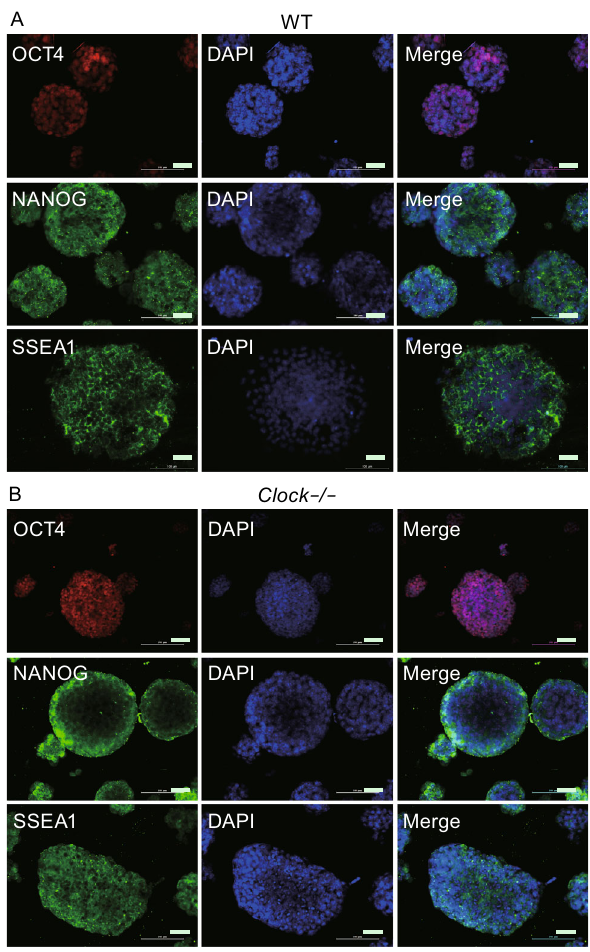
Figure 3. Clock -/- mESCs express pluripotent markers OCT4, NANOG, and SSEA1. (A) Immuno fl uorescence staining of the pluripotent markers OCT4, NANOG, and SSEA1 in wild type mESCs. (B) Immuno fl uorescence staining of the pluripo- tency marker OCT4, NANOG, and SSEA1 in Clock -/- mESCs. Bars, 100